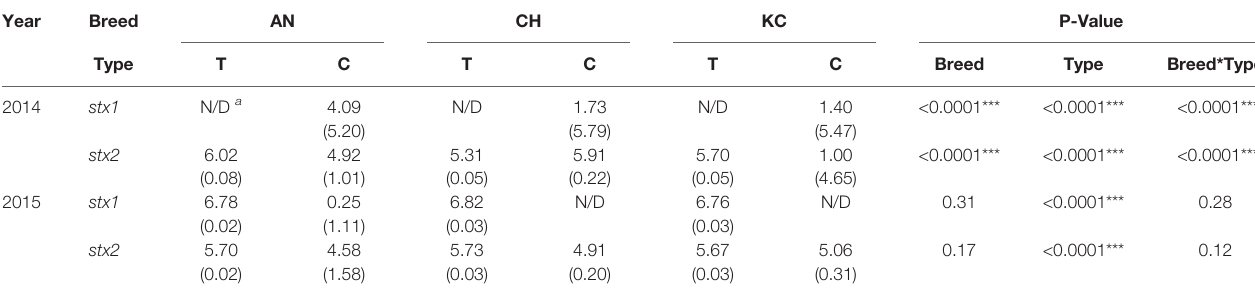
TABLE 3 | Abundance of stx1 and stx2 using q-PCR for samples collected from the rectal tissue and content in 2014 and